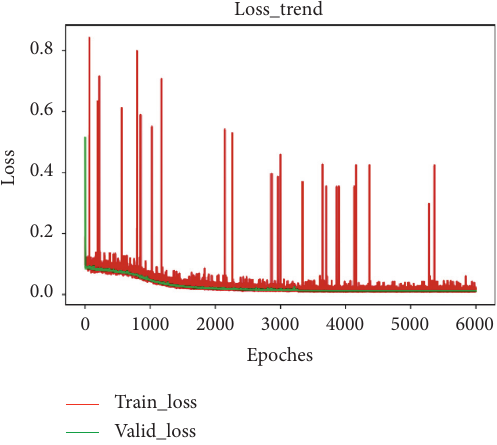
Figure 5: Training process of trajectory prediction model without vehicle